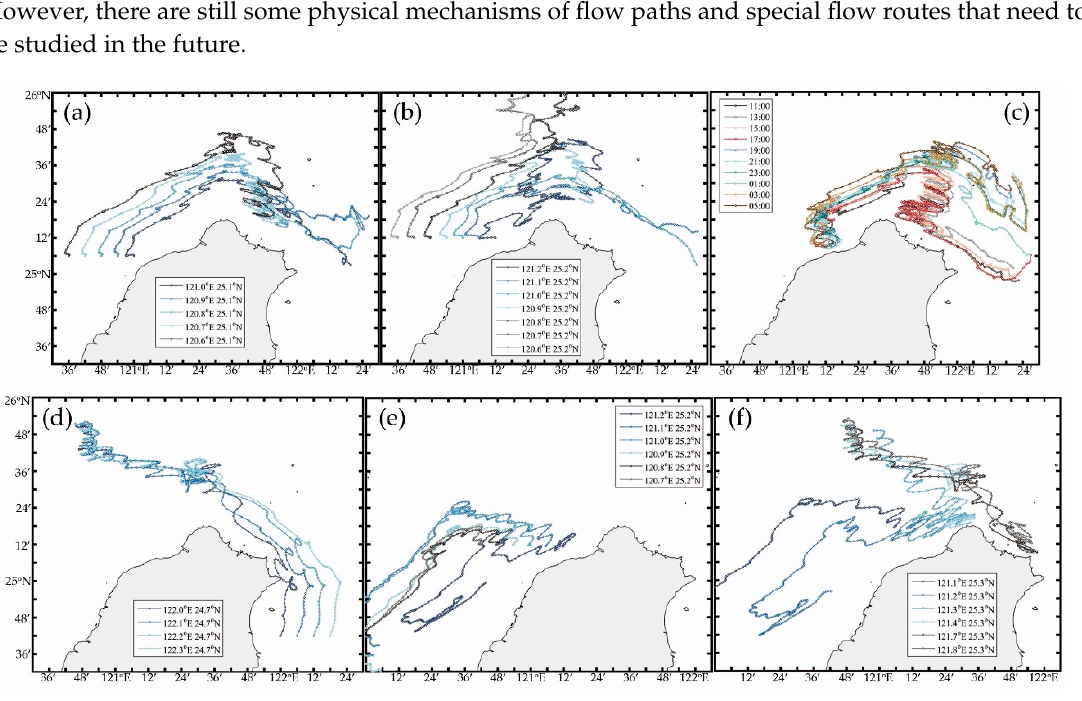
Figure 16. Simulation of virtual drifter trajectory using CODAR flow field data, simulation time of drifter on ( a , b ) 11:00 (UTC) 18 July, 2015, ( c ) from 11:00 (UTC) 8 July to 05:00 (UTC) 9 July, 2015, and ( d – f ) 0:00 (UTC) 19 February, 2016.